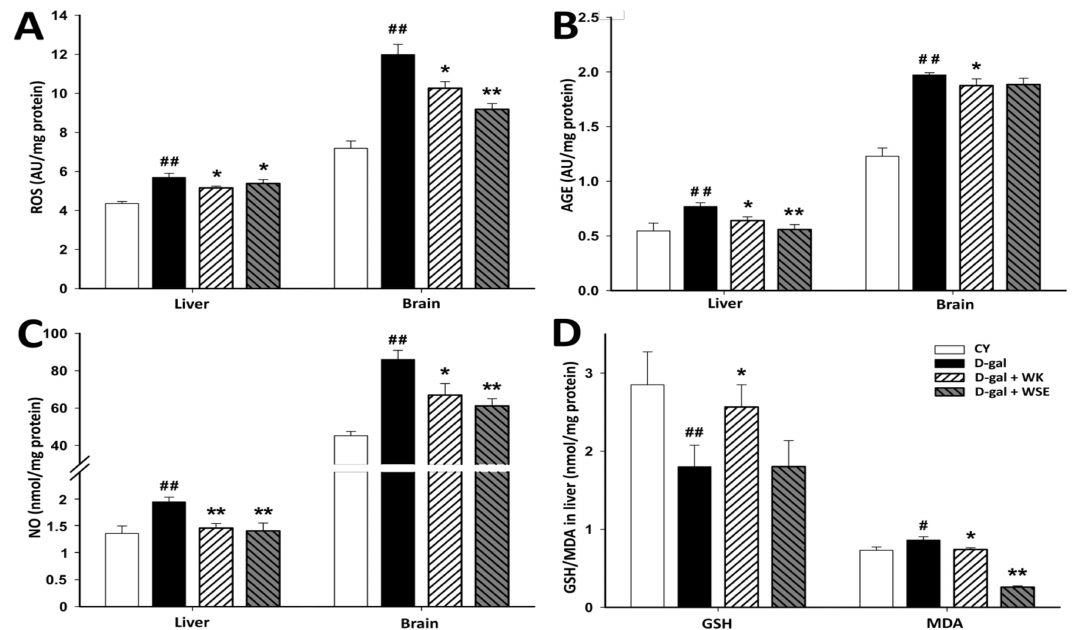
Figure 6. The e ff ects of walnut kernels (WK) and a walnut septum extract (WSE) on oxidative stress biomarkers in D-gal-induced aging model (values expressed as mean ± SD; n = 5); # p < 0.05 and ## p < 0.01 compared to CY; * p < 0.05 and ** p < 0.01 compared to D-gal group (AGE – advanced glycation end products; CO—control old; CY—control young; D-gal—D-galactose; GSH—total glutathione; MDA—total malondialdehyde; NO—total nitric oxide; ROS—reactive oxygen species). ( A ) ROS; ( B ) AGE; ( C ) NO; ( D ) GSH / MDA in